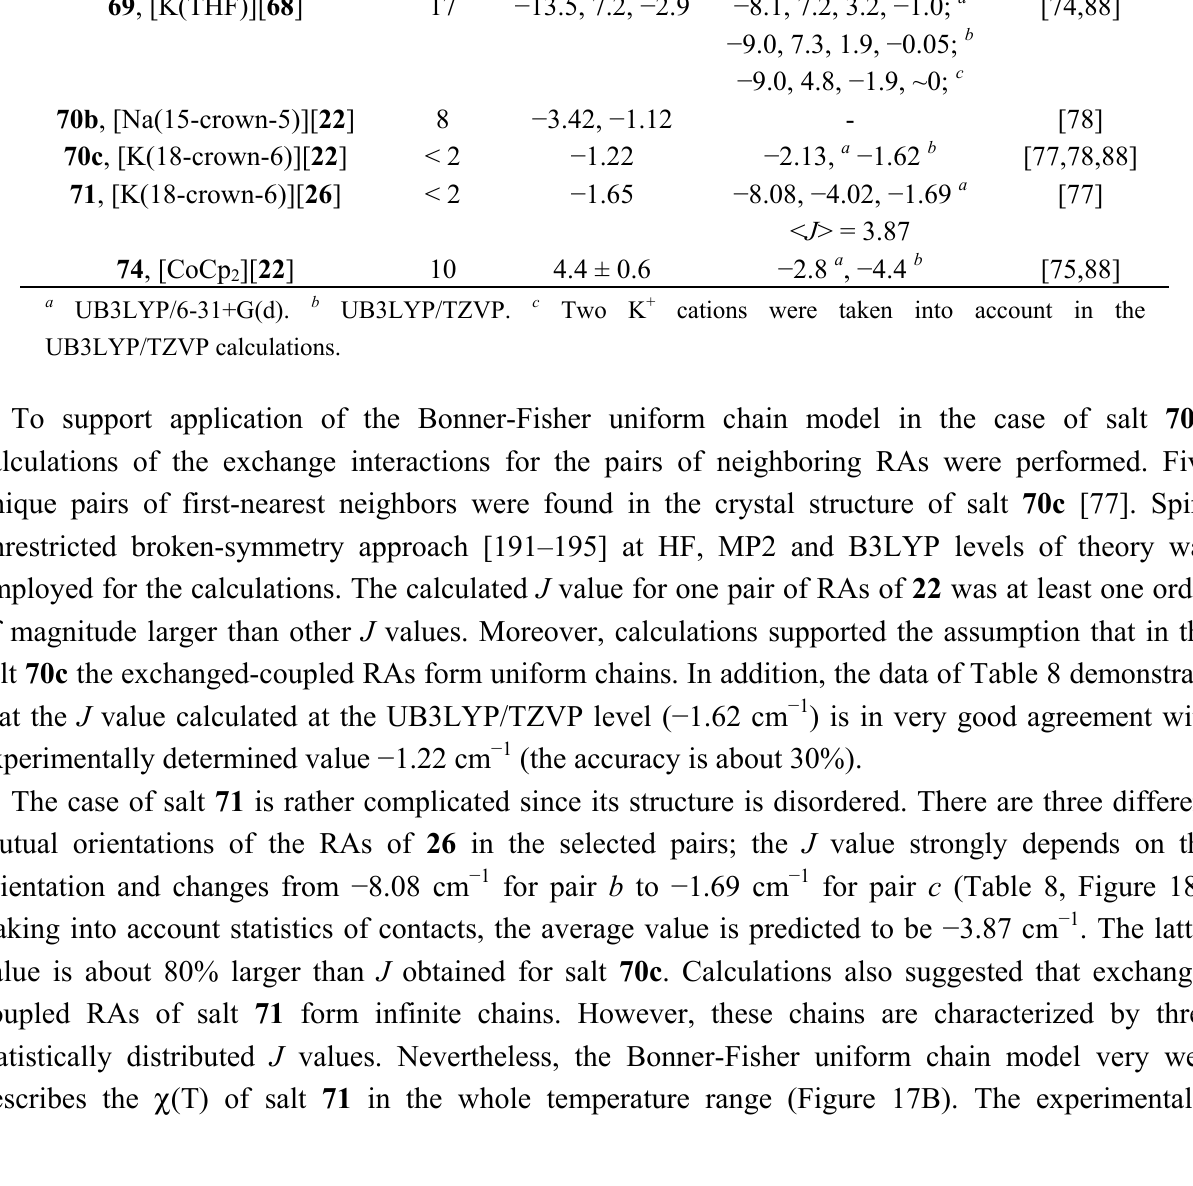
Table 8. Experimental and calculated parameters ( J ) of pair exchange interactions and ) for a series of homospin RA salts. Neel temperature ( T N J , cm − 1 RA salt T , K N Experiment